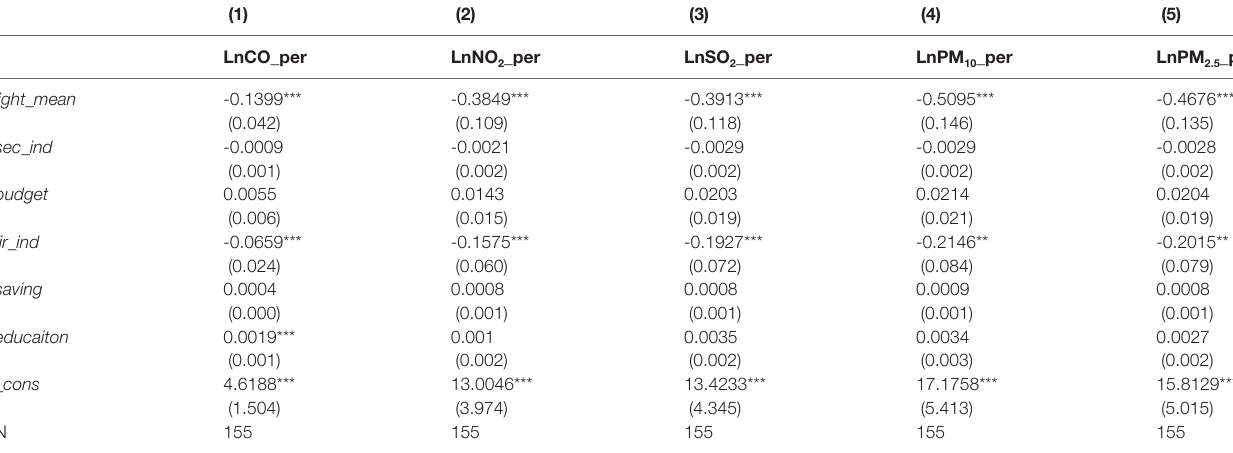
TABLE 11 | The impact of economic development on air pollutants intensity with replacing explained